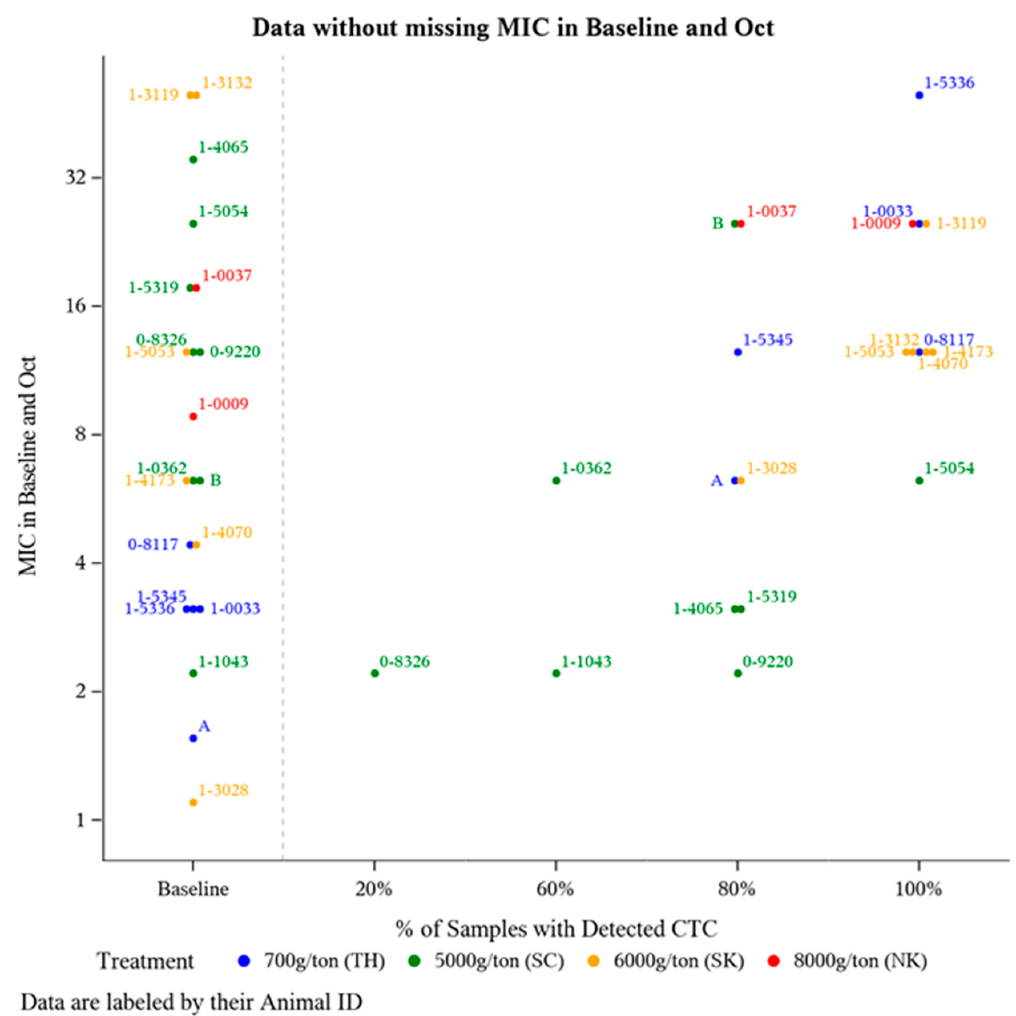
Figure 2. Distribution of E. coli isolate MIC levels pre-CTC treatment versus post-CTC treatment relative to the frequency of detectable plasma CTC levels. Of the 36 animals with detectable plasma CTC concentration at a minimum of 2 sampling time points, 21 animals had a MIC measurement at both Baseline (May) and the final time point in October.